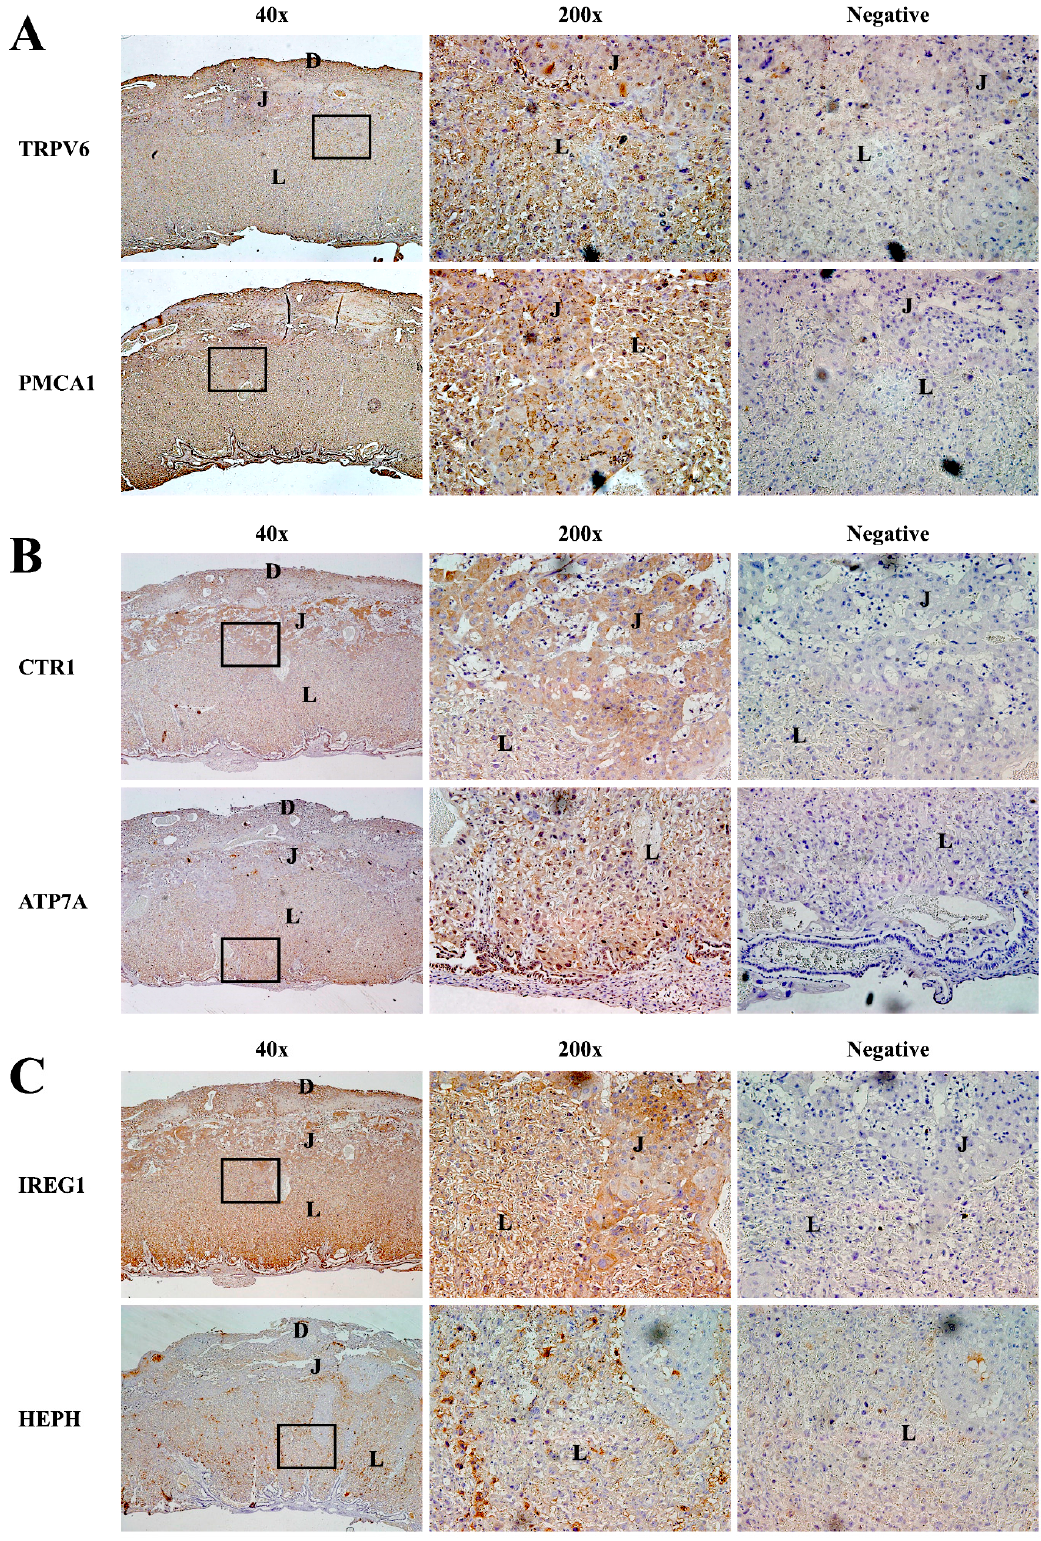
Figure 4. Localization of cation transporter channels in mouse placenta. Localization of calcium ( A ), copper ( B ), and iron ( C ) transporter channel in the placenta of pregnant mice were confirmed using immunohistochemistry. Cation transporter channel proteins on gestational date (GD) 17.5. ( Left ): 40 × magnified view of placenta, ( Mid ): 200 × magnified placenta region containing labyrinth (L), junctional (J), decidua (D) and ( Right ): 200 × negative controls were stained in the absence of primary antibodies. Regions containing brown color indicate cation transporter channel expression.